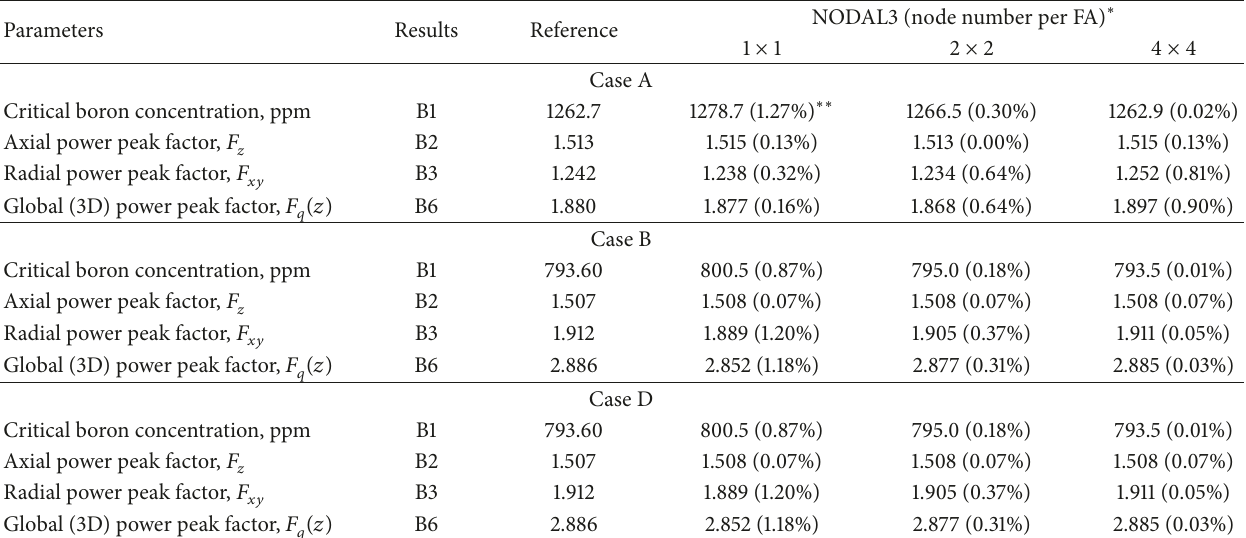
Table 2: Effect of radial node number per FA for steady-state parameters in Cases A, B, and